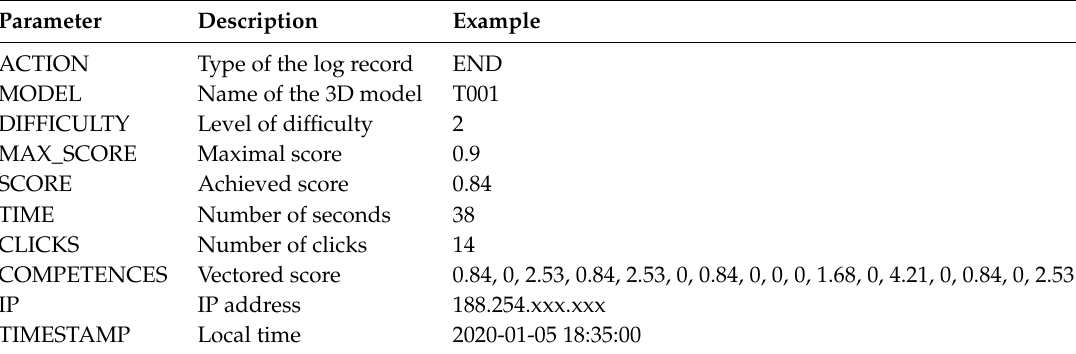
Table 2. Log data when a model is closed.